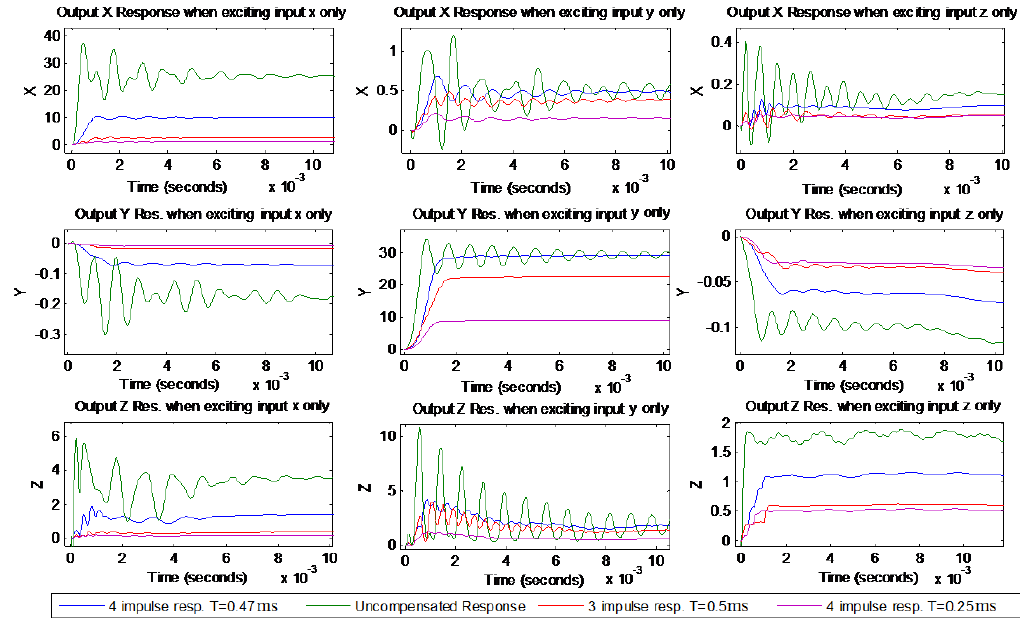
Table 1. Settling time for all responses.